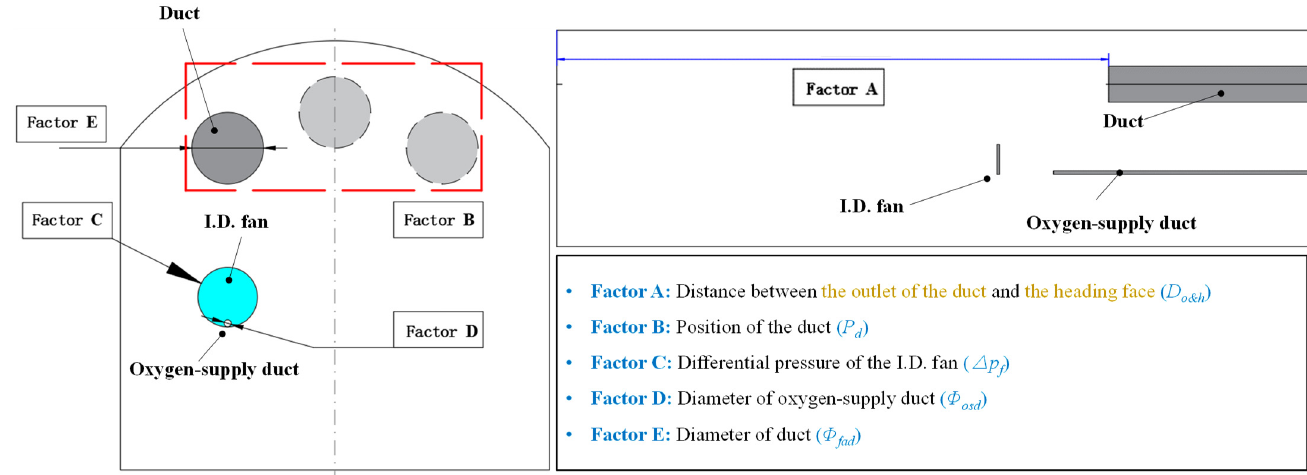
Figure 2. Orthogonal experimental factors of the study.